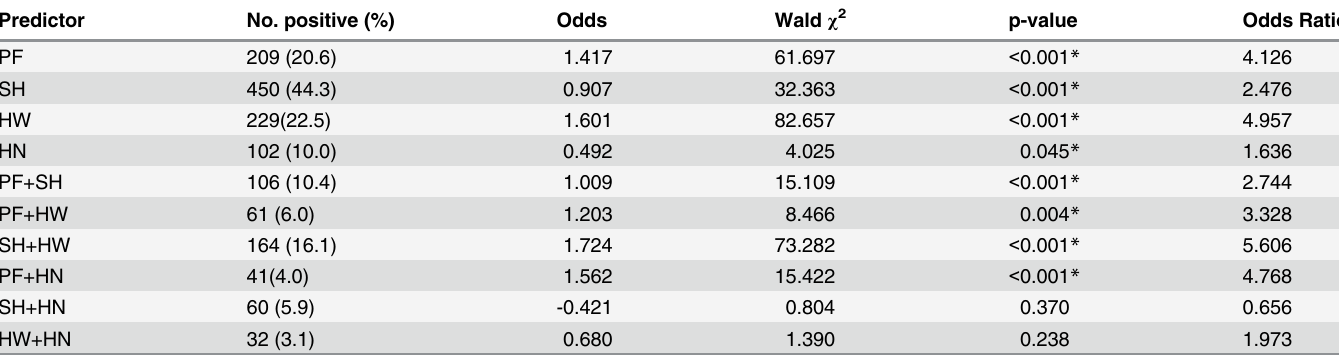
Table 6. Logistic regression predicting the occurrence of anemia in relation to parasitic infection among the school children.